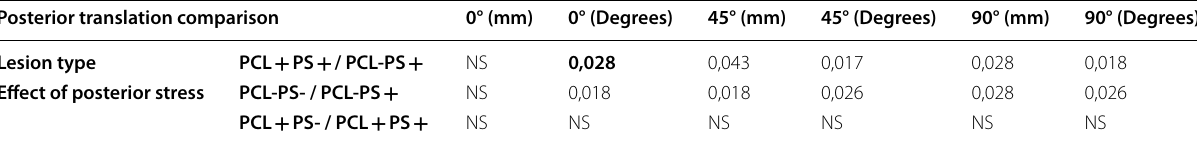
PCL Posterior cruciate ligament, PS Posterior stress